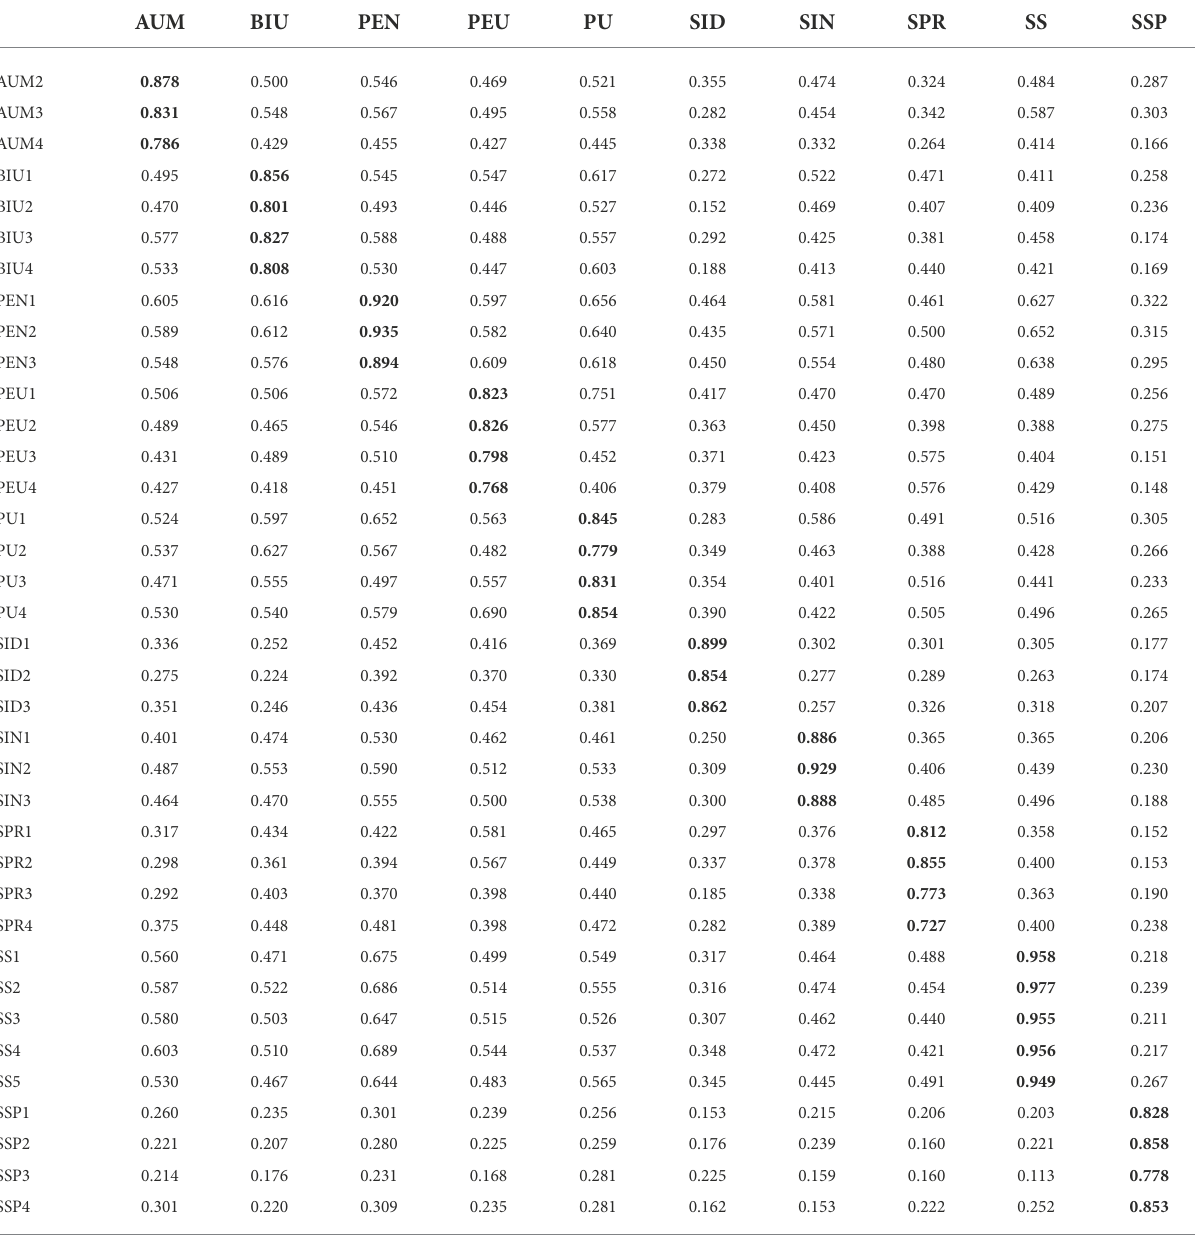
TABLE 3 Loading and cross-loading of